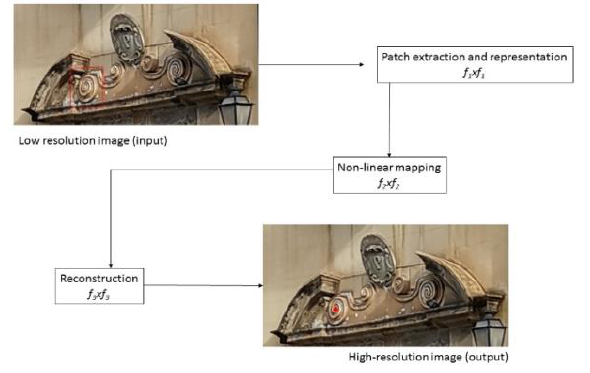
Figure 5: In the picture, there are three different layers: f 1 xf 1 , f 2 xf 2 , f 3 xf 3 . Starting from a low resolution image (Y), the first